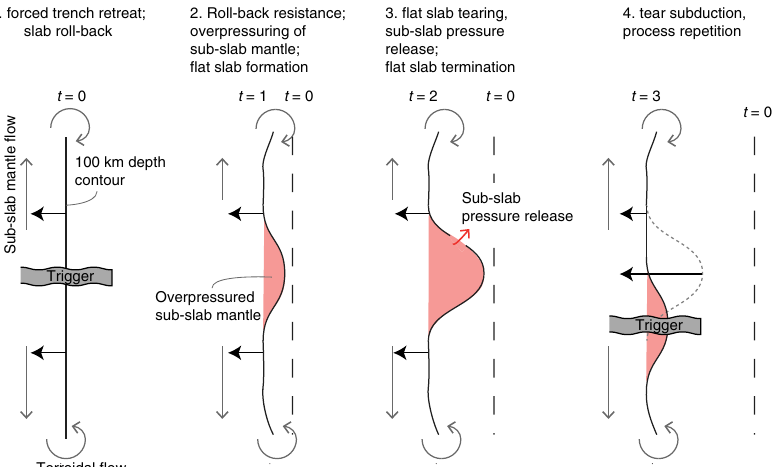
Figure 7 | Conceptual model of the formation of overpressured sub-slab mantle dynamically supporting flat slabs in a top view of the 100km depth contour line. Stage 1 represents the rollback of a slab with trench-parallel mantle flow, toroidal flow and the arrival of a triggering mechanism (for example, arrival of more buoyanty material at the trench) for a decreased subduction angle, for example, a more buoyant body of lithosphere. Stage 2: mantle trapped below the flatter subduction segment in the overall context of slab rollback is trapped and becomes overpressured dynamically supporting a flat slab segment. Stage 3: the stresses on the flat slab segment induce tearing and sub-slab overpressure is released; flat slab roll-back occurs. Stage 4: slab segment with the slab tear progressively subducts to deeper levels and is replaced at shallower levels by slab material that is geomorphologic regions, which are represented by the areas between different feldspars, zircon fission track, zircon (U-Th)/He, apatite fission track and apatite polylines in the reconstruction. Each polyline is subdivided in smaller portions (U-Th)/He analyses. These indicate that Andean deformation occurred mainly in based on the locations of cross-sections. These lines move with respect to each the last 50Ma (ref. 29). Paleomagnetically documented rotation patterns in the other during deformation and change in the area in between them reflects Central Andes reveal counterclockwise rotation to the North, and clockwise documented shortening. We reconstruct Andean deformation with respect to rotations to the South of the Arica bend. Andean paleomagnetic data were a fixed non-deforming South American continent in the east. primarily derived from volcanic forearc rocks and not from the retroarc fold-thrust belt where most deformation occurred since 30 and thus reflect the total rotation differences accommodated through regional shortening variations in the Andean Constraints used for reconstruction . The kinematic reconstruction of the Andes fold-thrust belt. Displacements along strike-slip faults, finally, are used where well constrained. For instance, geological and seismologic data indicate that the is primarily based on shortening estimates from a total of 50 published balanced Cochabamba and the Rio Novillero Faults are left-lateral and right-lateral cross sections. Shortening directions have been reconstructed parallel to balanced respectively, although the amount of displacement is poorly constrained 29 . The sections where no vertical axis rotations were documented. For the timing of displacement and timing along the Magallanes–Fagnano fault system are also still deformation, we followed the interpretations of the authors of the balanced cross under debate. The proposed displacements are in the same order of magnitude sections, who generally constrained timing from stratigraphic ages of basin (20–55km) but the age of formation ranges from 100 to 7Ma (ref. 62). deposits, in combination with thermochronology from 40 Ar/ 39 Ar of micas and